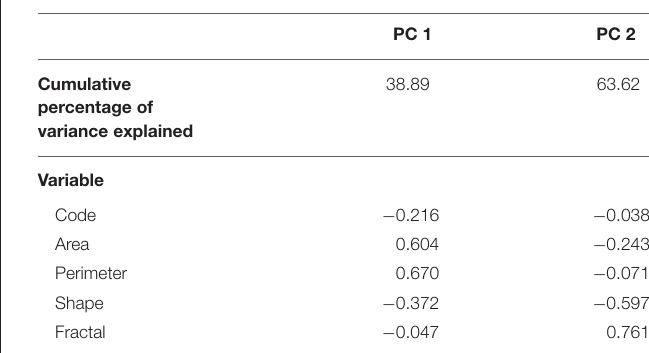
TABLE 2 | Eigenvalues for the principal components analysis for channeled and unchannelled valley-bottom wetlands by municipality based on area, perimeter, shape, and fractal